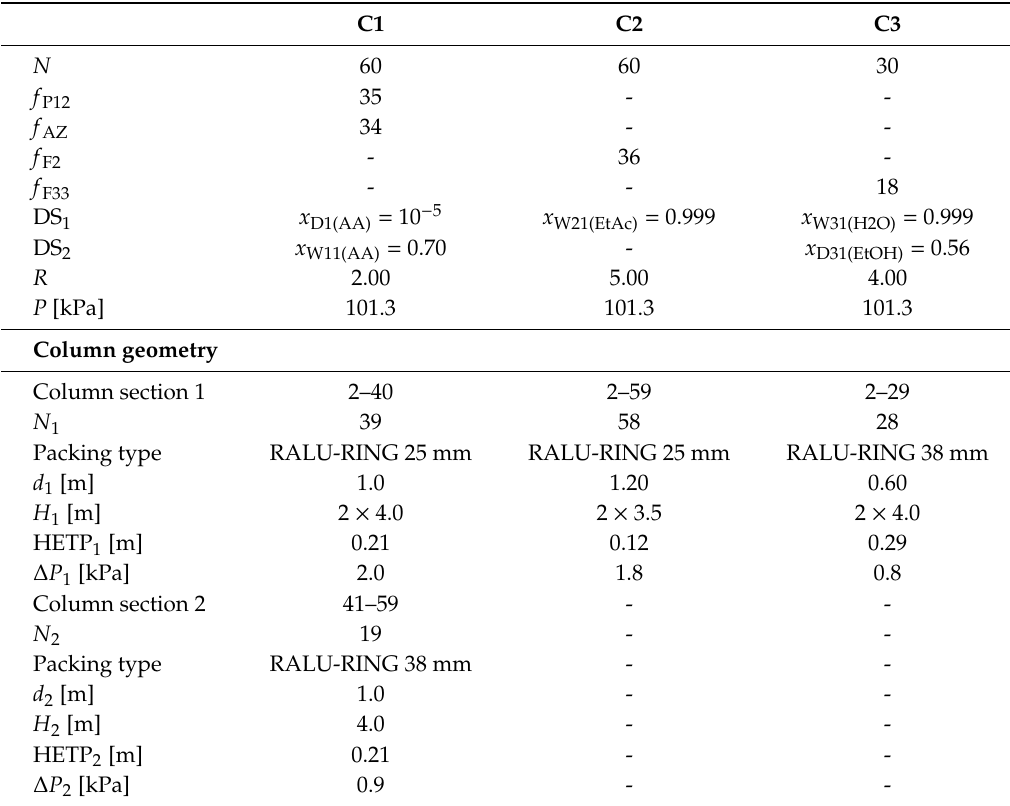
Table 2. Parameters of designed columns—conventional set-up (Figure